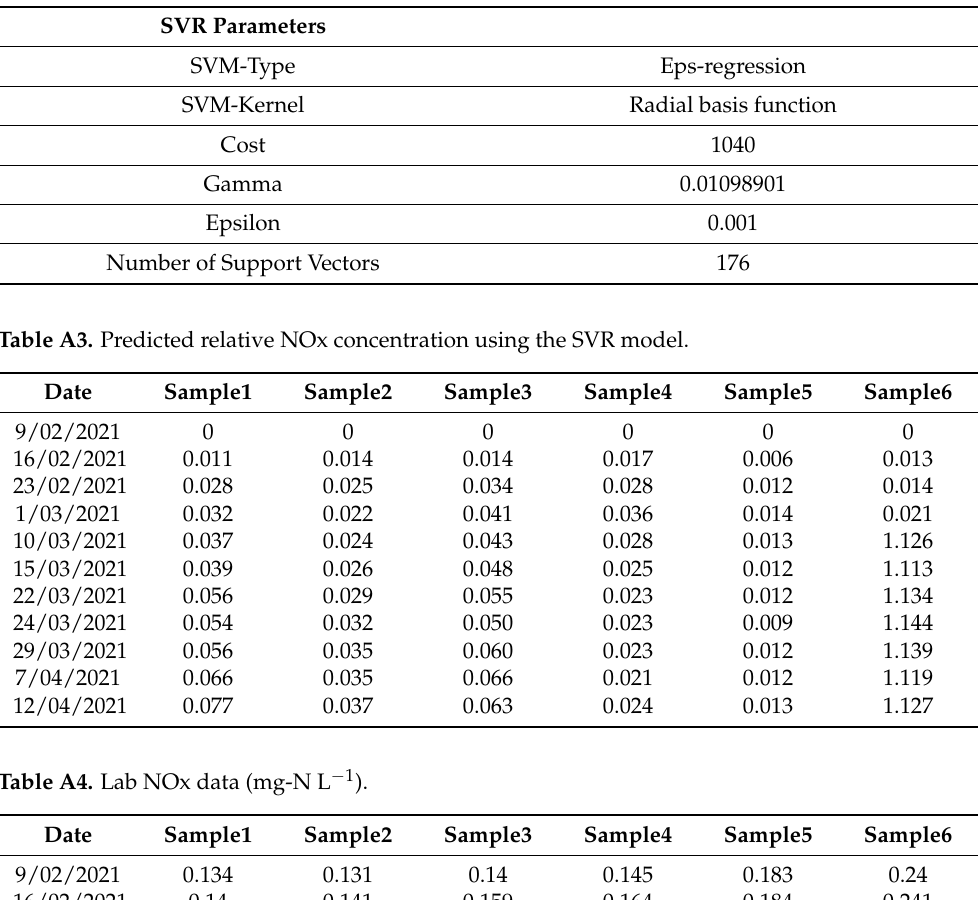
Table A2. SVR model details.